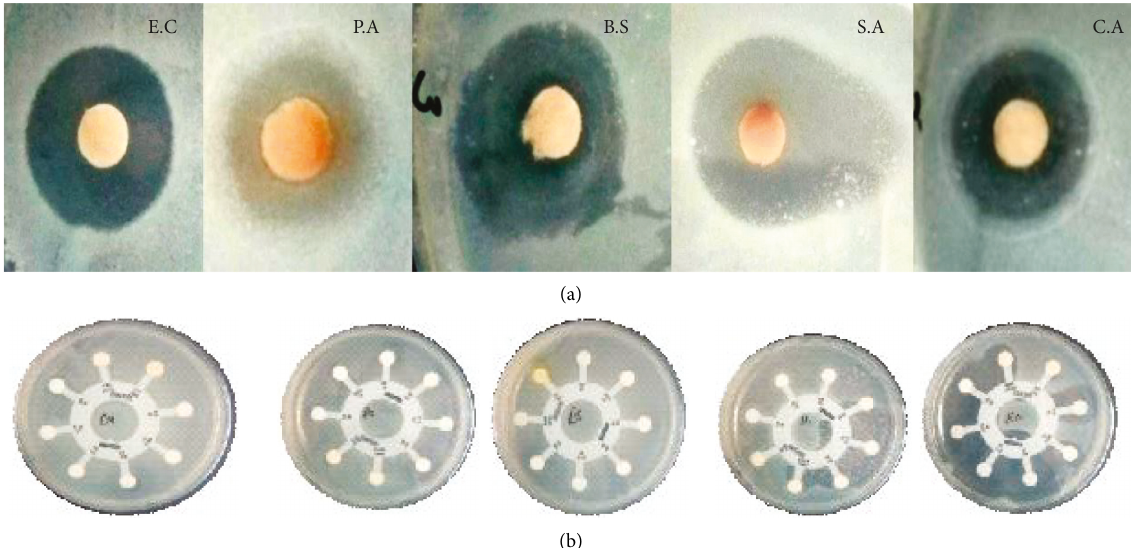
Figure 5: (a) Zone of inhibition of Au NP aqueous solution prepared using 100mM Au + . (b) Zone of inhibition of standard